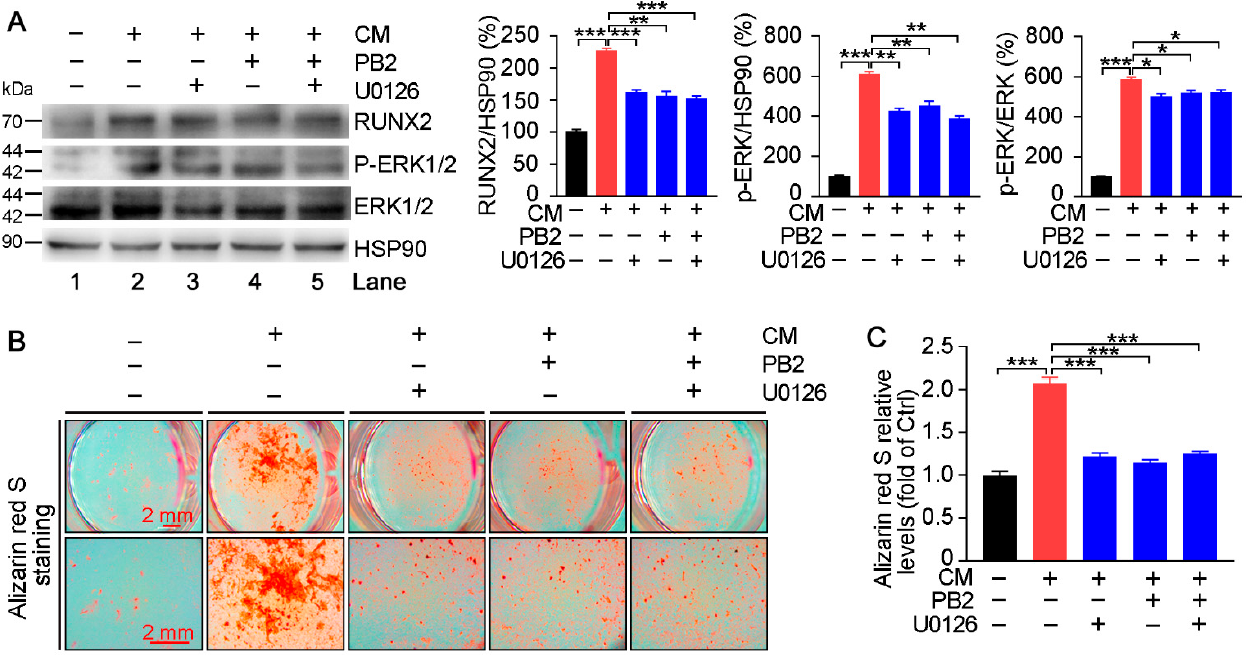
Figure 7. U0126 decreases PB2-inhibited RUNX2 expression and calcification in vitro. HASMCs were cultured in a normal medium, CM, CM plus U0126, or CM plus U0126 and PB2 for 7 ( A ) or 14 days ( B , C ). The expression of RUNX2, p-ERK1/2, and ERK1/2 was determined by Western blot ( A ). * p < 0.05, ** p < 0.01, *** p < 0.001 ( n = 3). Calcium deposition in cells was determined by alizarin red S staining, and images photographed by a microscope ( B ). Cells were then used to extract dye, and the absorbance of extraction solution at the 405 nm wavelength was measured ( C ). *** p < 0.001 ( n = 3). To further explore the role of the inactivation of ERK1/2 on PB2 ‐ inhibited vascular